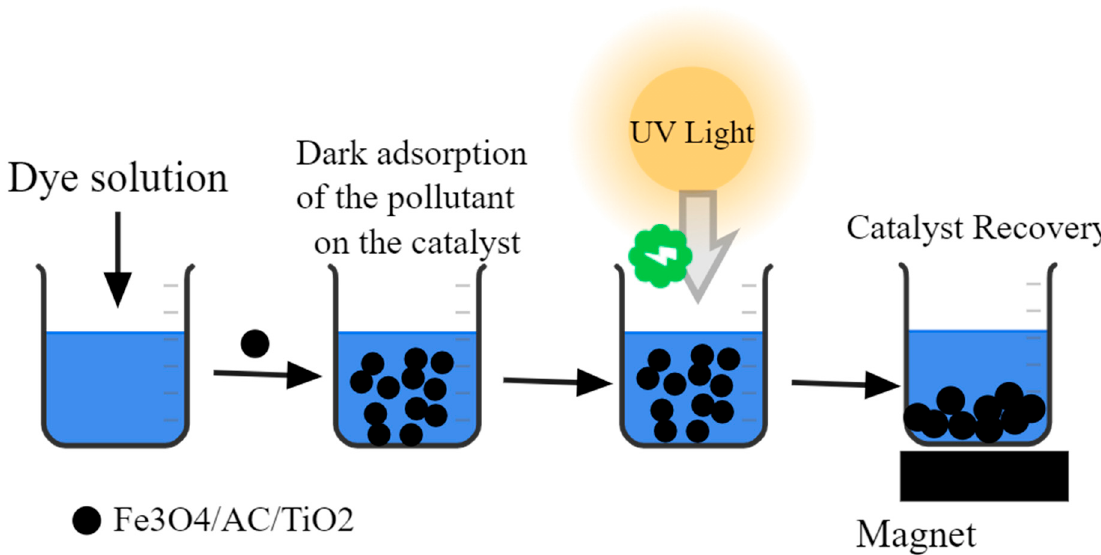
Figure 10. Recycling potential of Fe 3 O 4 /AC/TiO 2 (1:2) for catalytic degradation during the 60-min reaction.